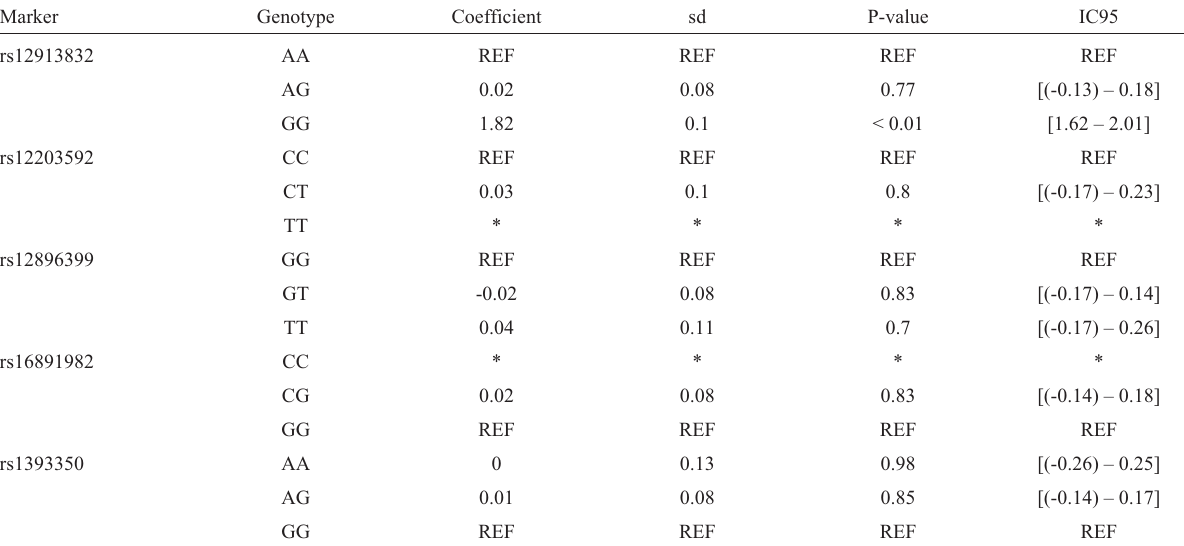
Table 2 - Results from median regression. REF: reference variable, sd: standard deviation, IC95: 95% confidence interval. *: removed from the analysis for being unrepresentative.